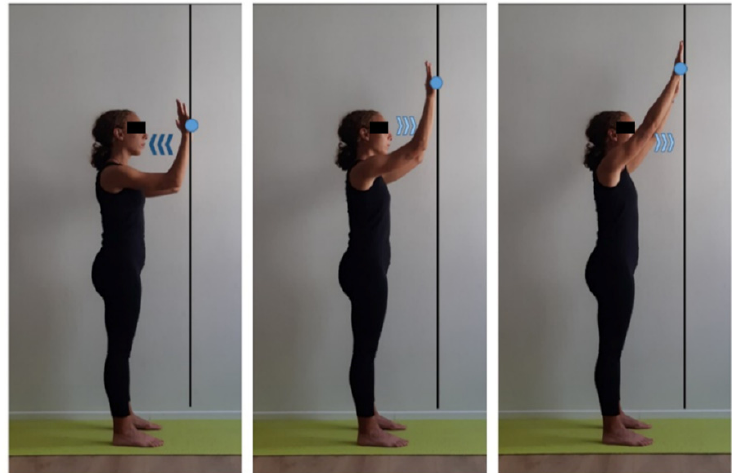
Figure 10. Scapulohumeral mobilization exercise in orthostatic position. Orthostatic position a step apart from the wall, lift both upper limbs and flex forearms placing the back of hands at gaze height (light blue dot), inhale (dark blue arrows). Exhale (light blue arrows) while performing an upward upper limbs extension. Focus on keeping trunk position, avoiding leaning back or forward. Three sets of 8 repetitions, 30 s recovery.